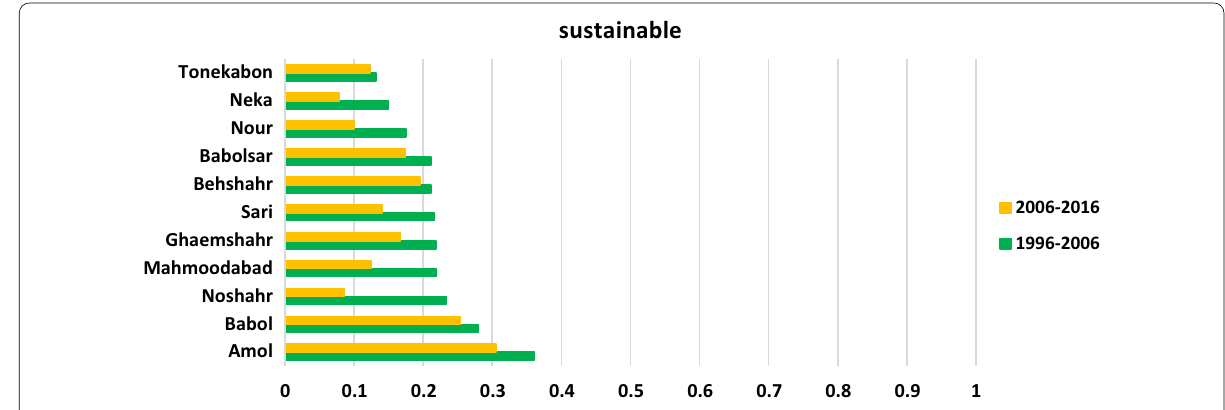
Fig. 8 Sustainability of the selected urban areas based on USI